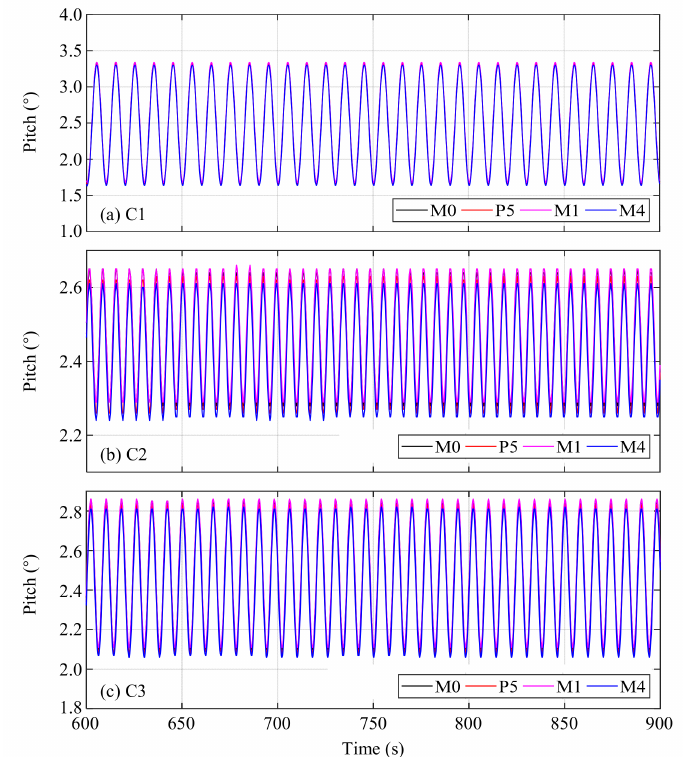
Figure 18. Wind turbine pitch movement time series with M0, P5, M1, and M4 when under: ( a ) C1; ( b ) C2; ( c )